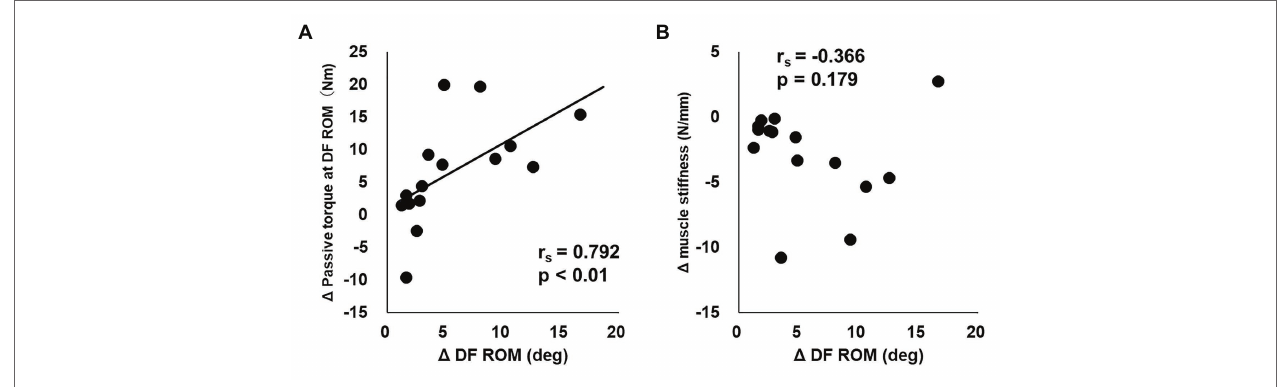
FIGURE 1 | The relationships between change in dorsiflexion range of motion (DF ROM) and change in passive torque at DF ROM (A) or change in muscle stiffness (B) from before to after 5-week stretching intervention program in static stretching intervention